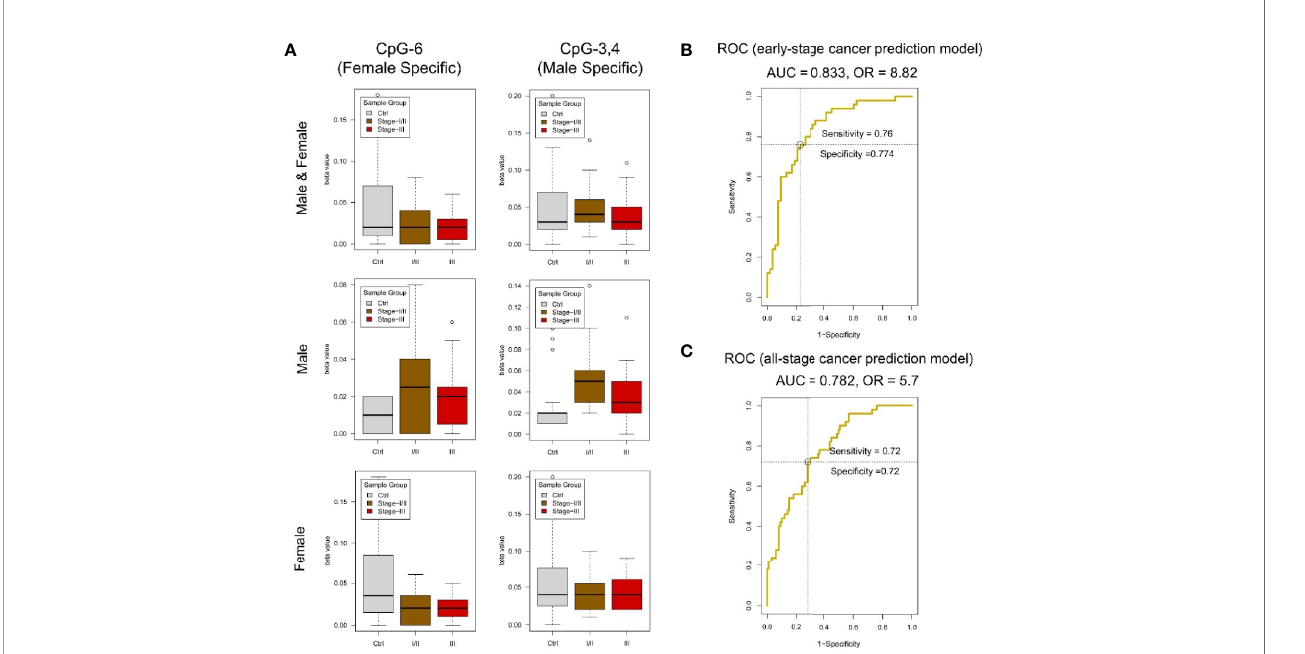
FIGURE 5 | DNA methylation analysis of amplicon-cg14787155 in DZIP3 . (A) Sex-speci fi c methylation level change between colorectal cancer and control in amplicon-cg14787155 . (B) ROC analysis of the early-pTNM-stage colorectal cancer prediction model based on the MassARRAY data of amplicon-cg14787155 features. The model with the best performance had an AUC of 0.833 and an OR of 8.82. (C) ROC analysis of the all-pTNM-stage colorectal cancer prediction model based on the MassARRAY data of amplicon-cg14787155 features. The model with the best performance had an AUC of 0.782 and an OR of 5.7.